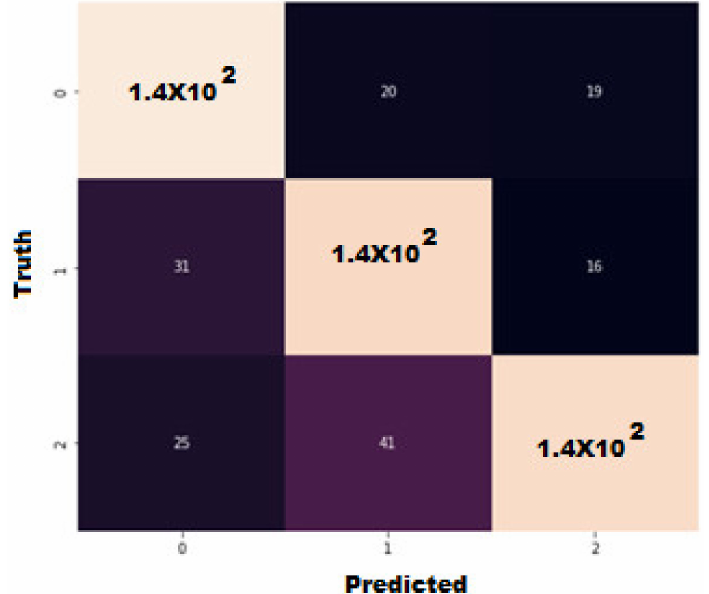
Figure 9. Confusion matrix of Gradient Boosting